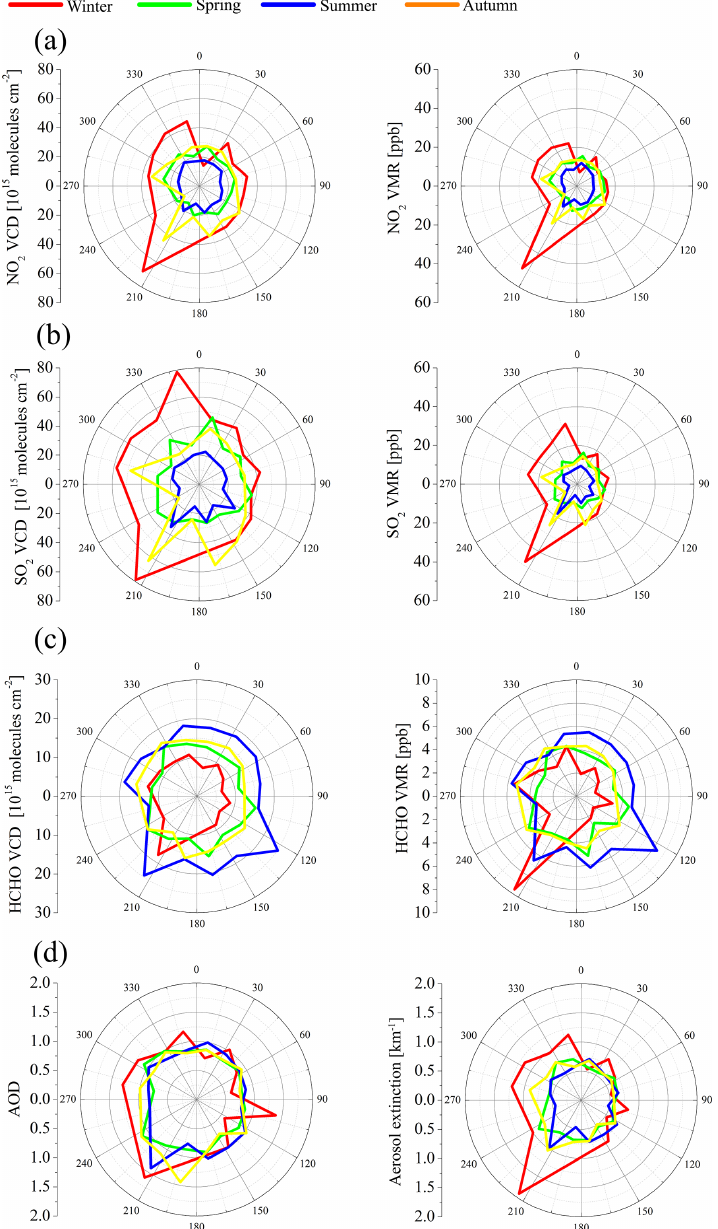
Figure 16. Dependencies of VCDs and AODs (left panels) and near-surface VMRs and AE (right panels) of NO 2 (a) , SO 2 (b) , HCHO (c) and aerosols (d) on wind direction for individual seasons (different